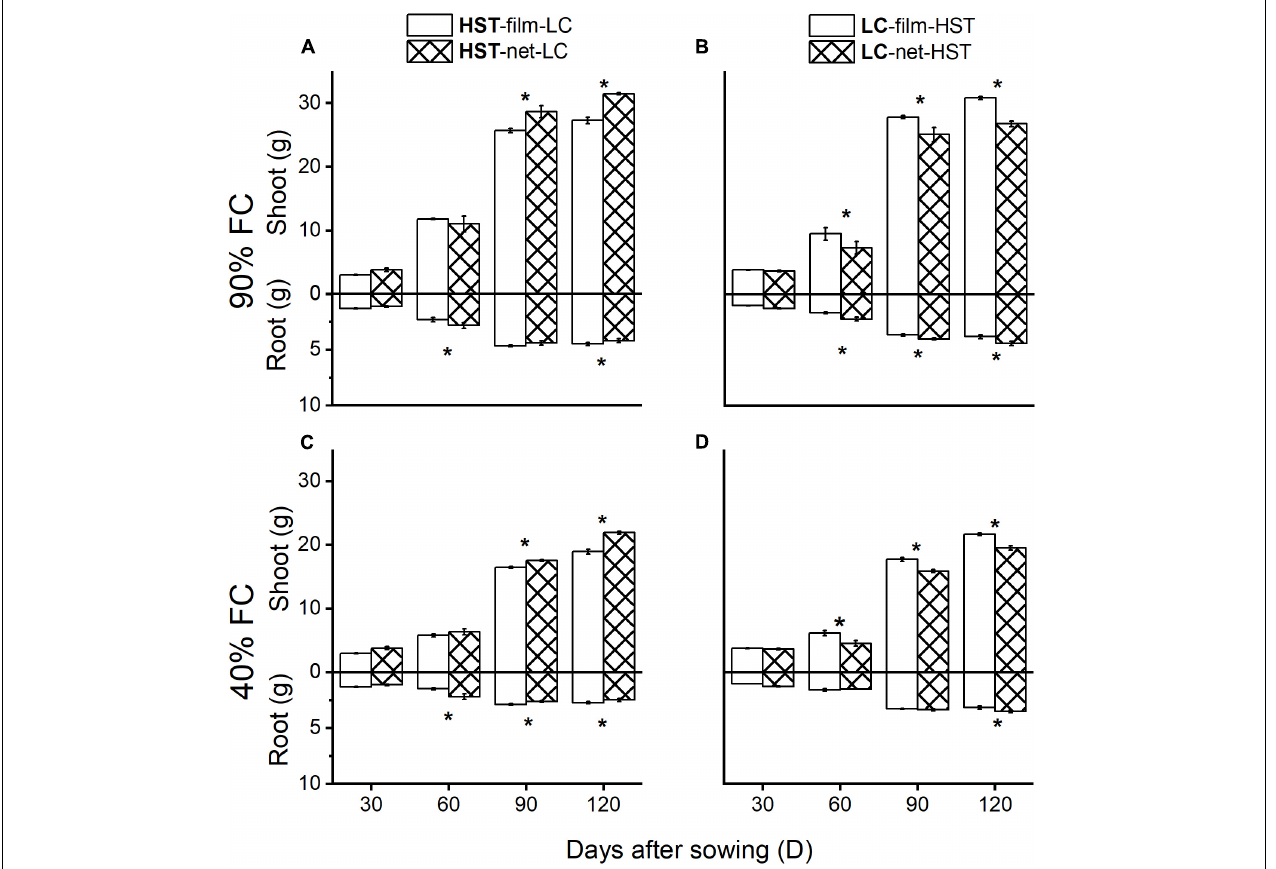
FIGURE 5 | Average shoot and root biomass of two cultivars. Samples from in inter-cultivar competition and eight plants/pot treatment in plant growth stage. Panels (A,B) at 90% field capacity (FC) and panels (C,D) at 40%. Panels (A,C) are cultivar HST and panels (B,D) are LC. The target cultivar is in bold. Asterisks indicate significant differences between two soil dividers ( P <